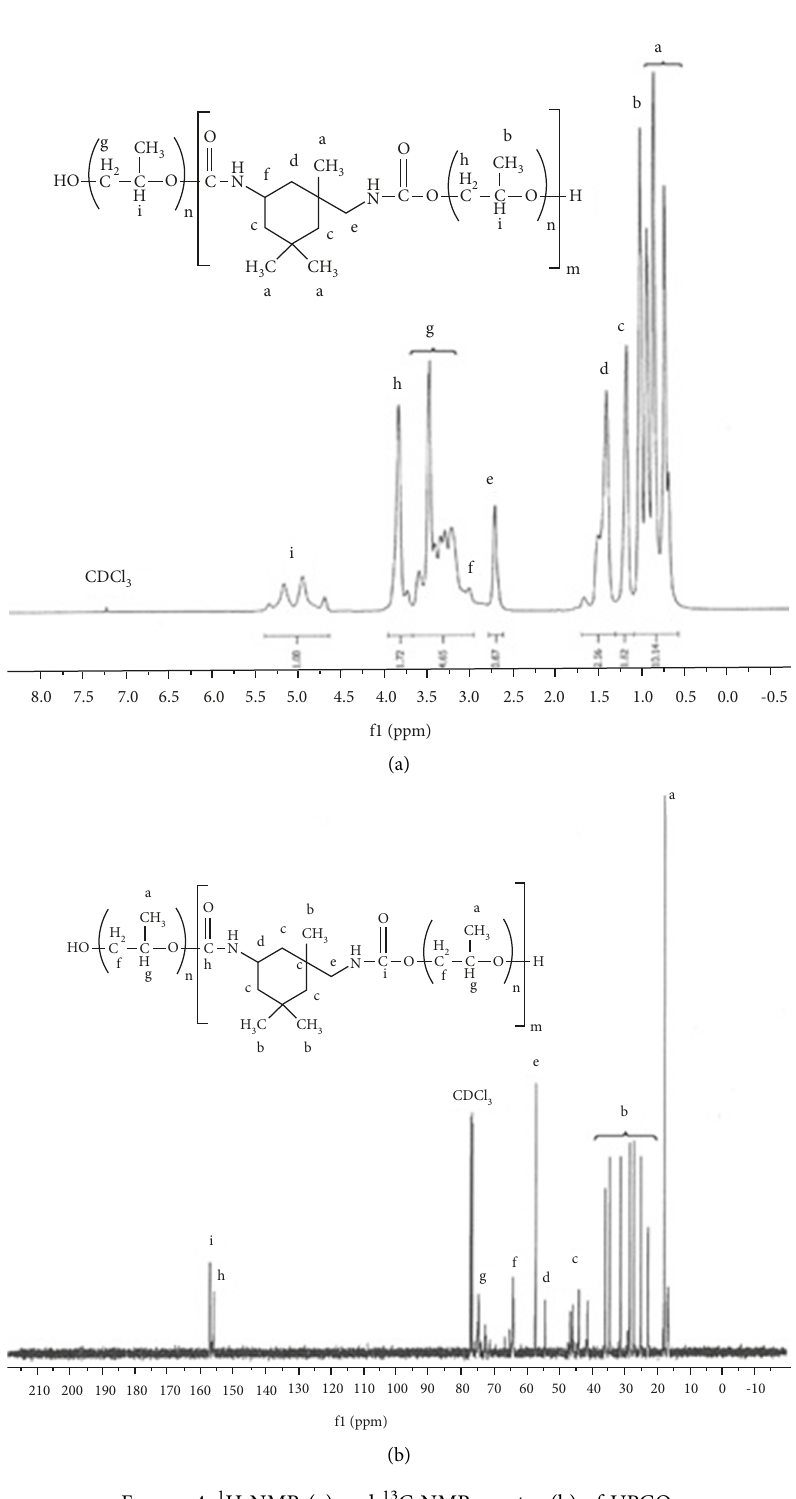
Figure 4: 1 H NMR (a) and 13 C NMR spectra (b) of